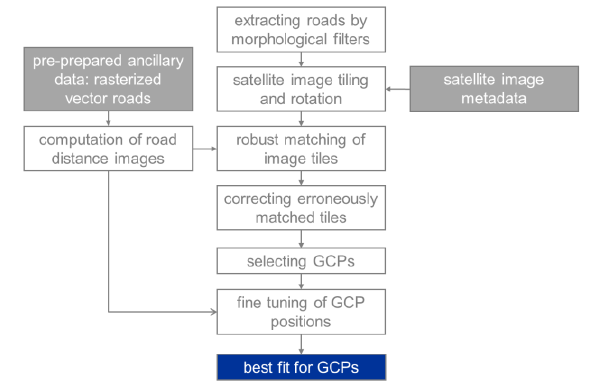
Figure 3. Workflow of the Automatic GCP Extraction